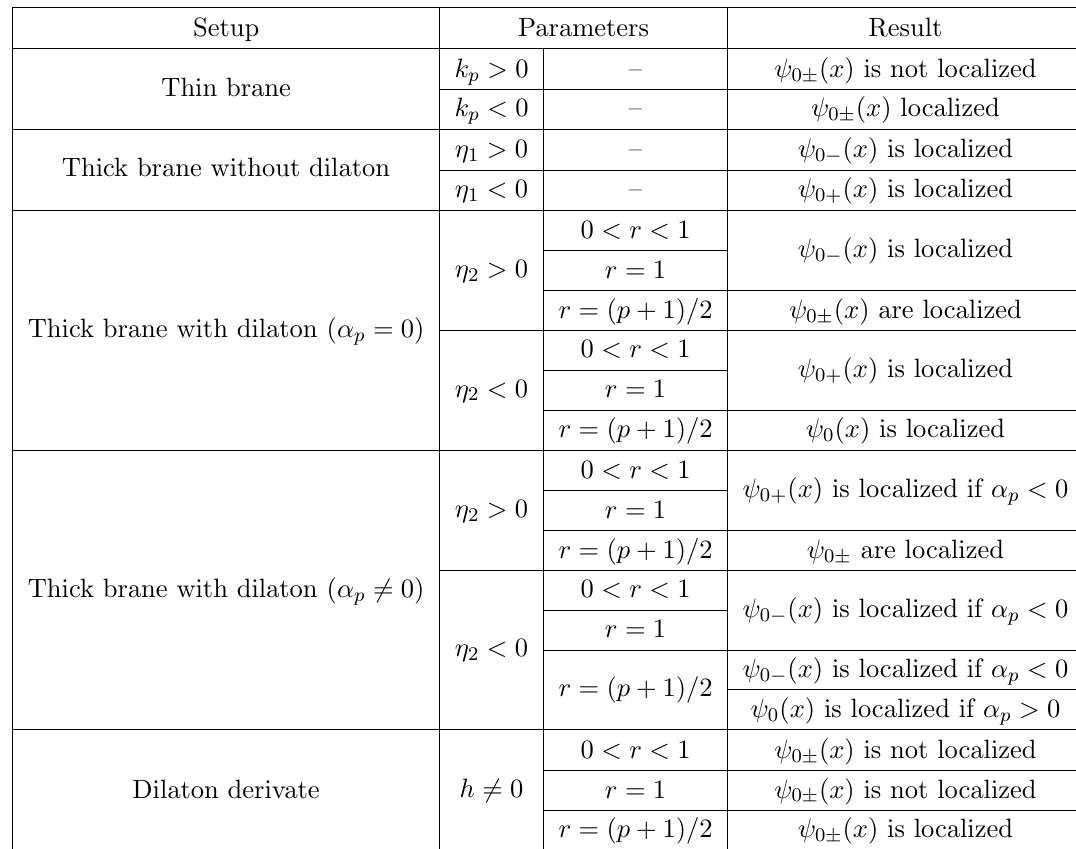
Table 6 . Summary of results of zero mode fermions localization in odd dimensions. The 0 ( x ) and 0 (cid:6) ( x ) are Dirac and Weyl spinors on the brane, respectively.